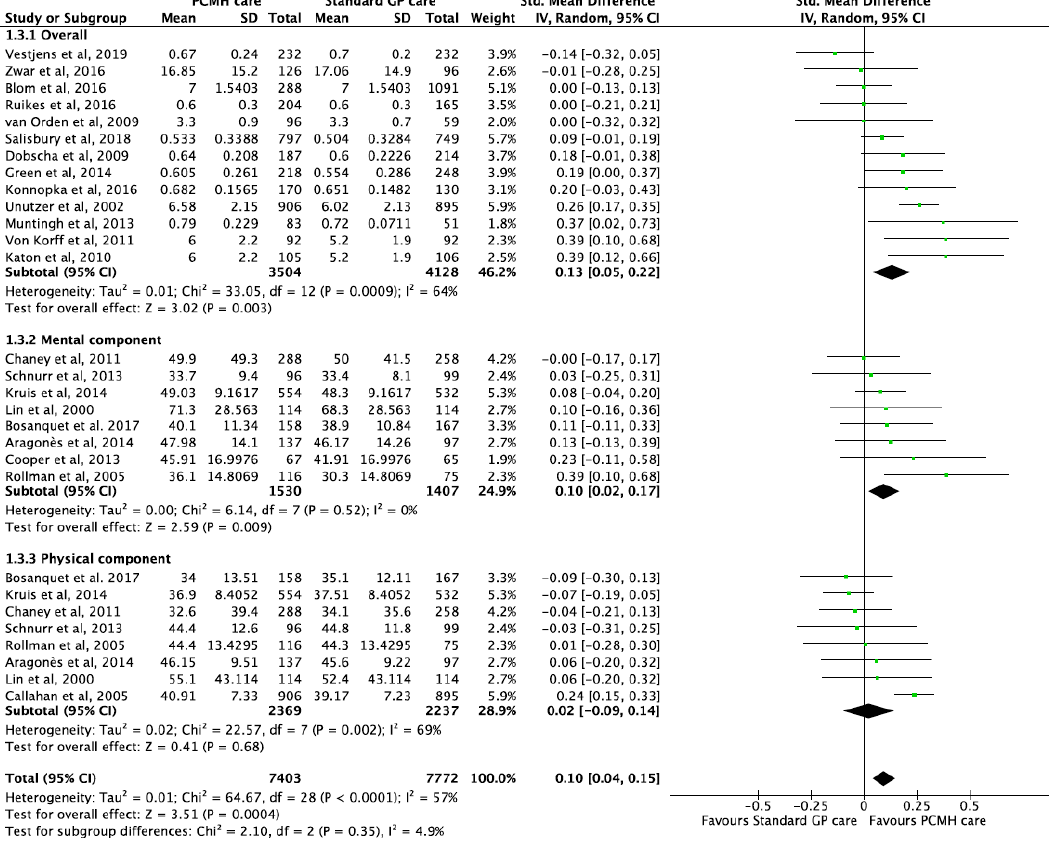
Figure 4. Forest plots of Quality of life (QoL) outcomes between the PCMH care and Standard GP care.